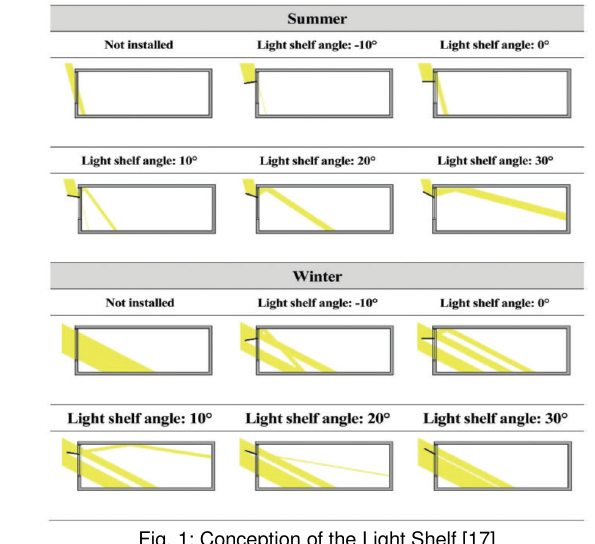
Fig. 1: Conception of the Light Shelf